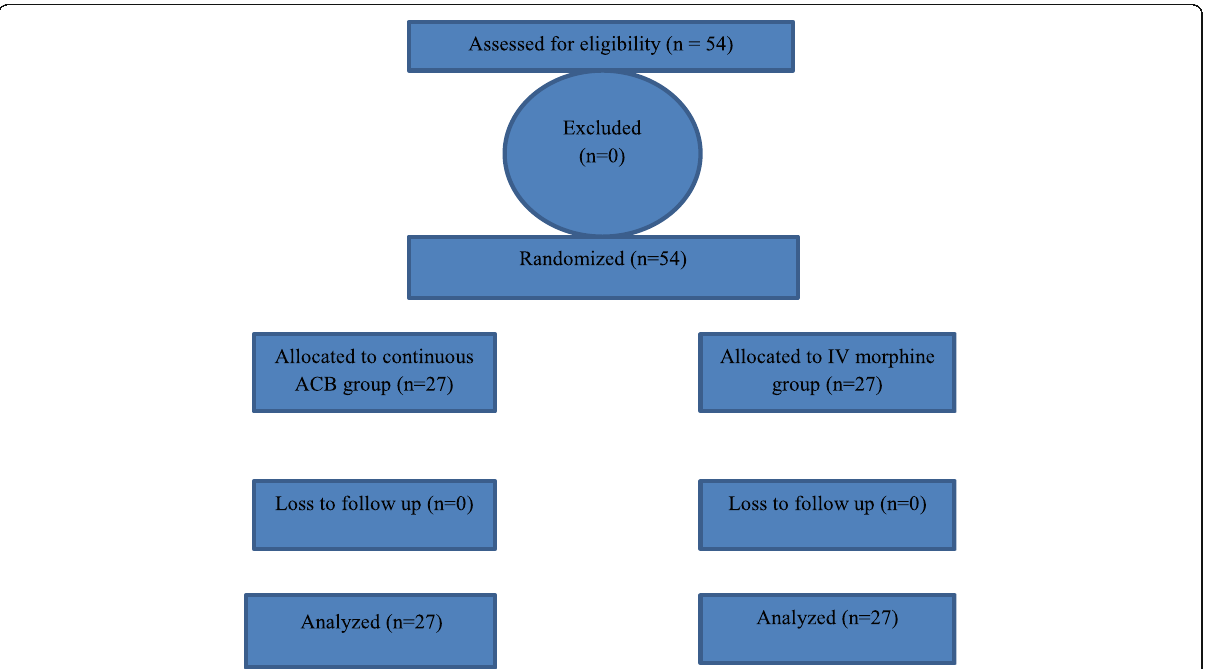
Fig. 1 Patient flowchart of comparative study between continuous adductor canal block and intravenous morphine for postoperative analgesia in total knee